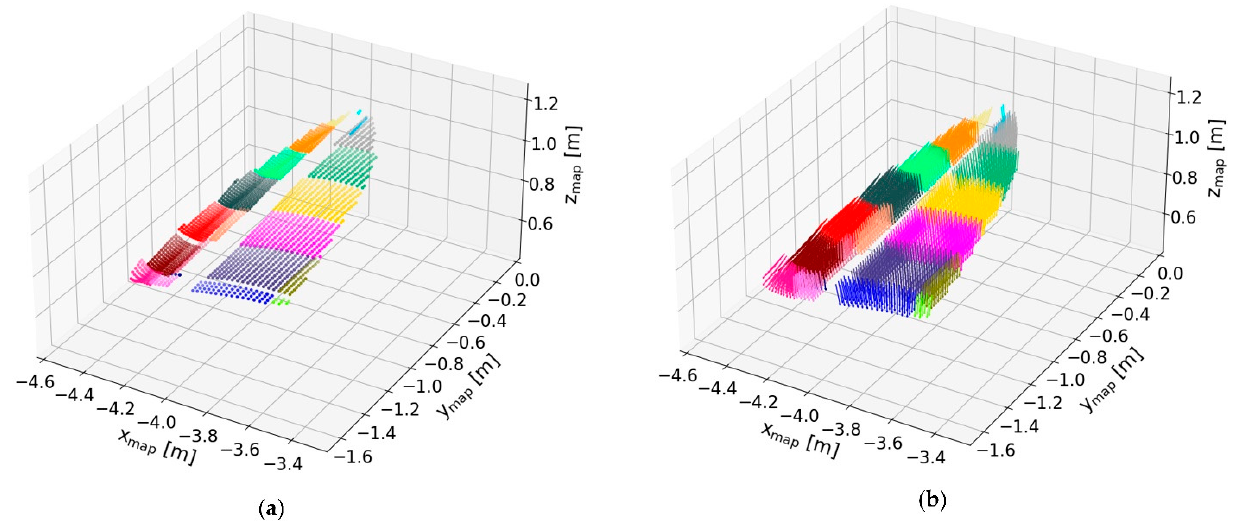
Figure 19. Execution of inspection process of the complete work piece. ( a ) 3D positions of the end-effector; ( b ) orientation of the end-effector at each 3D position.